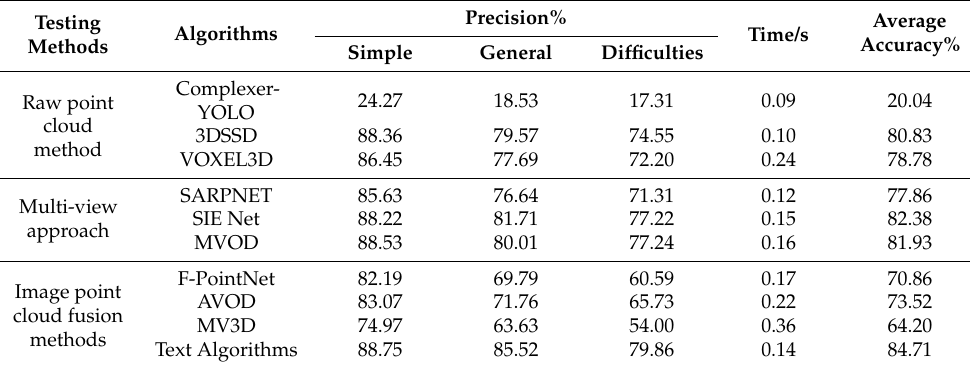
Table 2. Comparison of time and accuracy of mainstream algorithms.